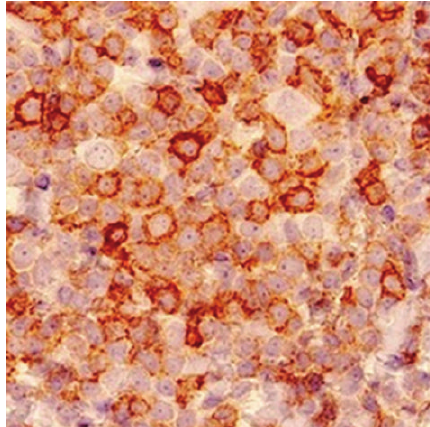
Figure 2: Positive immunohistochemical staining for CD5.